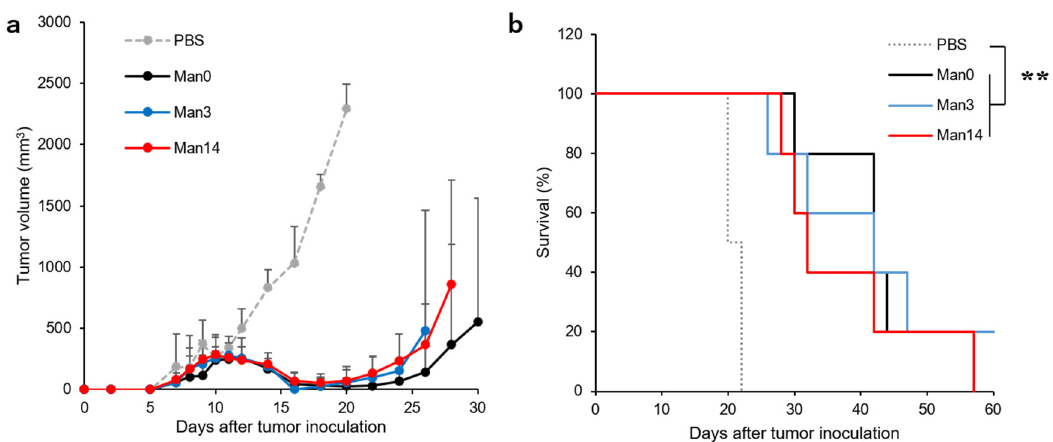
Figure 6. Antitumor effects induced by subcutaneous administration with OVA-loaded liposomes. C57BL/6 mice were immunized on days 5 and 8 with PBS or liposomes modified with curdlan derivatives. Changes in tumor volume ( a ) and survival ( b ) of mice were monitored after E.G7-OVA cells (0.5 × 10 6 cells/mouse) inoculation. All treated groups contained five mice. Statistical analysis was done using Log-rank test for ( b ). ** p < 0.01.